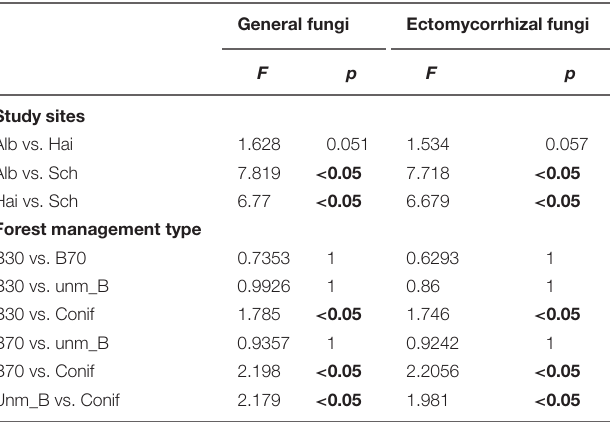
TABLE 3 | Community comparison among the three study sites and four forest management